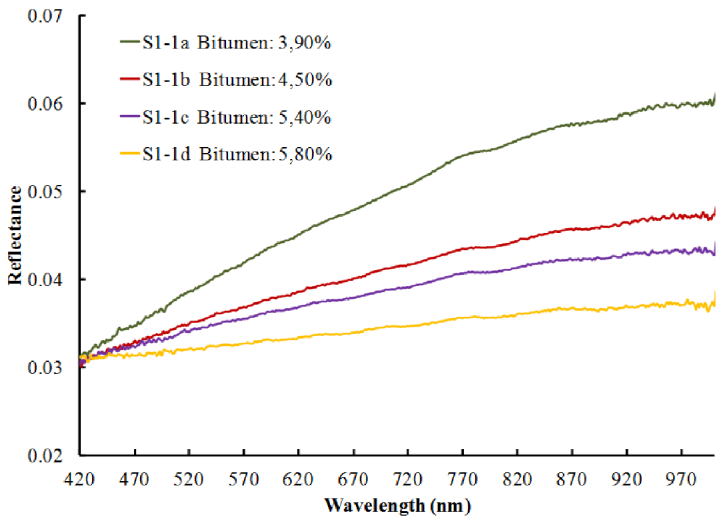
Figure 4. Spectra 4 mixtures (S1-1) with a different percent of bitumen by dry weight of aggregate.